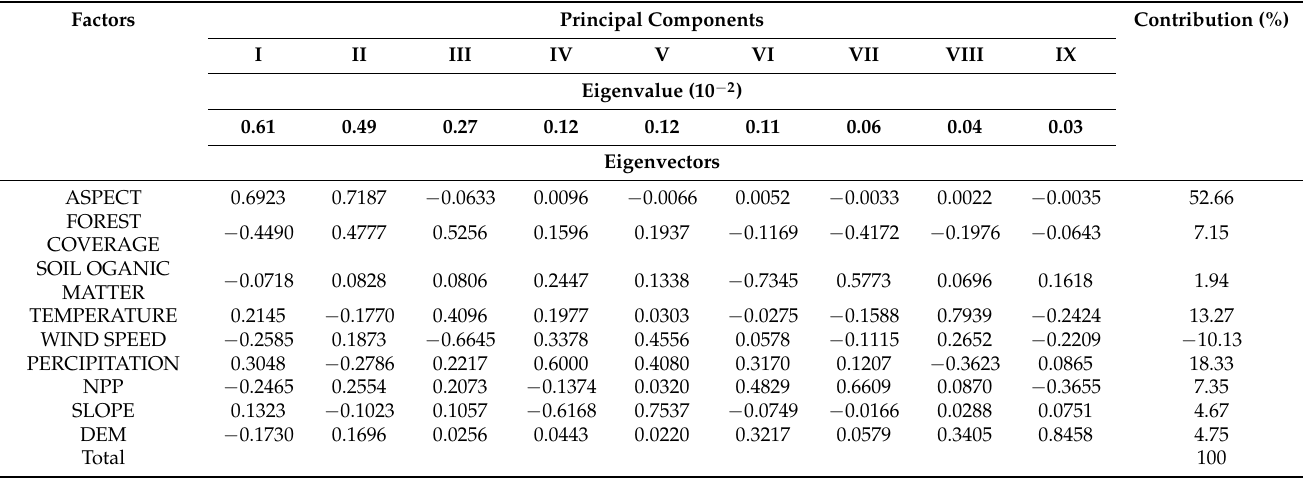
Figure 4. VNF spatial distribution ( left ) and area statistics of the five vulnerability levels ( right ) from 2000 to 2015. The histogram represents the area of each level, and the line chart represents the percentage area of each level. Table 2. The different index contribution of